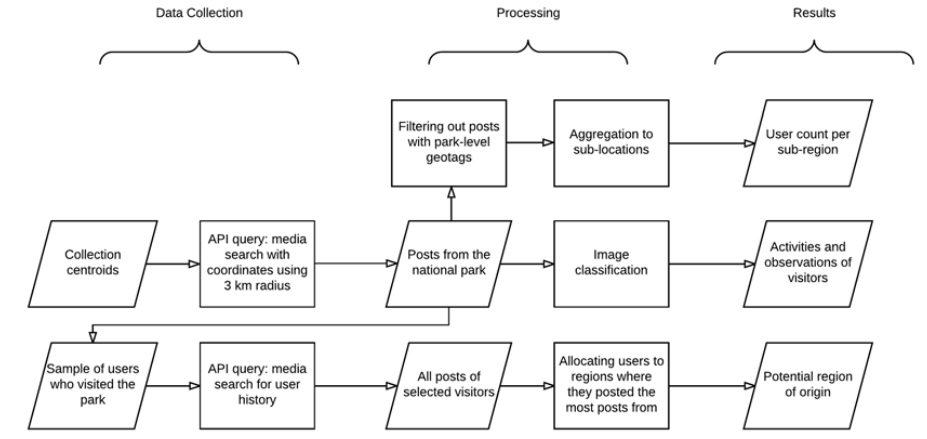
Figure 2. Social media data collection and pre-processing. API, Application Programming Interface.